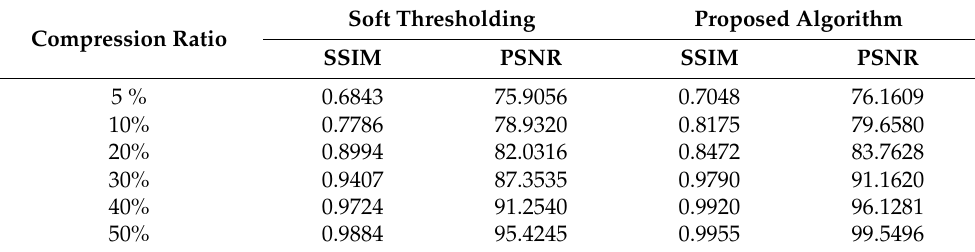
Figure 10. ( a ) Original 2D Brain MR Image, ( b ) Conventional Soft Thresholding based recovered 2D MRI, ( c ) 2D Brain MR Image recovered from undersampled image, ( d ) Difference of original and soft thresholding image, ( e ) Difference of proposed recovery method image with original image. The Difference is scaled up by the factor of 1000 in order to enhance its visibility. Table 2. Performance comparison of conventional soft thresholding and proposed method with different compression levels, i.e., 5% to 50% of subsampling of the original 2-D MR image. These results show that the proposed method achieves better results in terms of SSIM and PSNR at varying compression ratios.